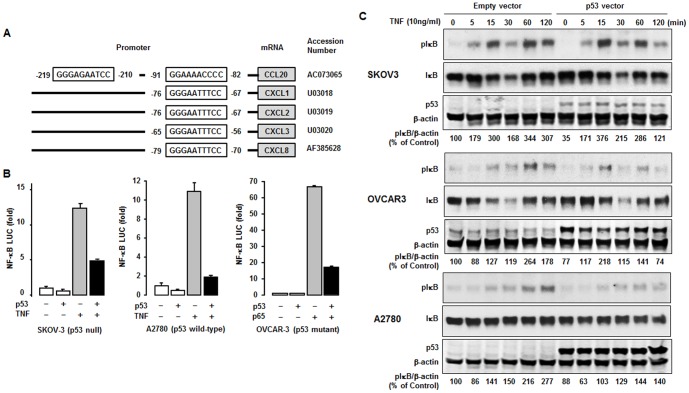
Overexpression of p53 inhibits NF-κB activity.(A) Nucleotide sequences of promoters for TNF-induced chemokines such as CCL20, CXCL1, 2, 3 and 8. These chemokine promoters contain one NF-κB site at the proximal region, except for CCL20, which has two NF-κB sites at the distal and proximal region. (B) Effect of p53 on NF-κB luciferase activity. After transfection of vectors or cotransfection with p65, cells were treated with TNF (10 ng/ml) for 4 h. (C) Effect of p53 on TNF-activated IκB. After transfection of empty vector or p53 in SKOV-3 (p53 null), OVCAR-3 (p53 mutant) and A2780 (p53 wild-type), cells were treated with TNF (10 ng/ml) for indicated times. β-actin serves as loading control. Experiments were performed in duplicate and a representative result is shown; numbers below are relative density values.